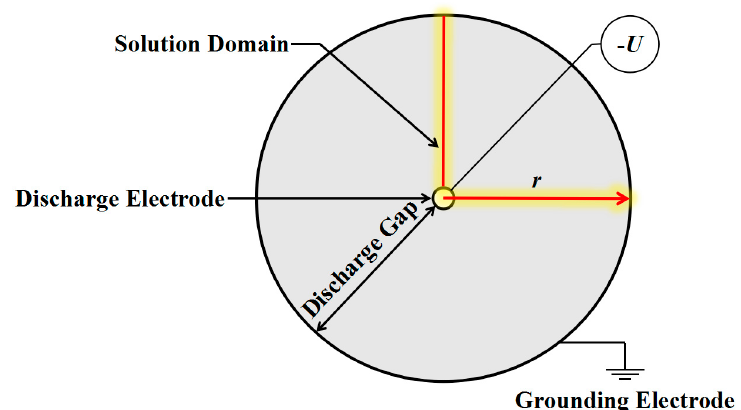
Figure 1. One-dimensional solution domain in the simplified physical model.